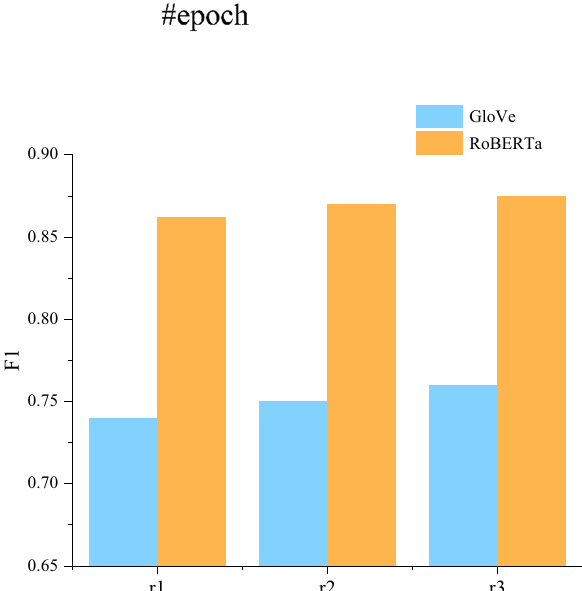
Fig. 12 Accuracy of ablation experiments on the 20NG dataset